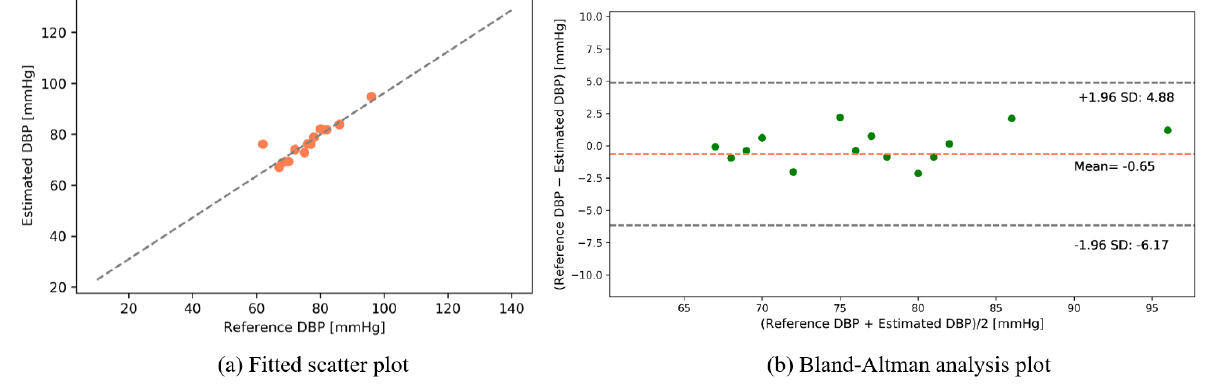
Figure 16. DBP estimation (self-made dataset).